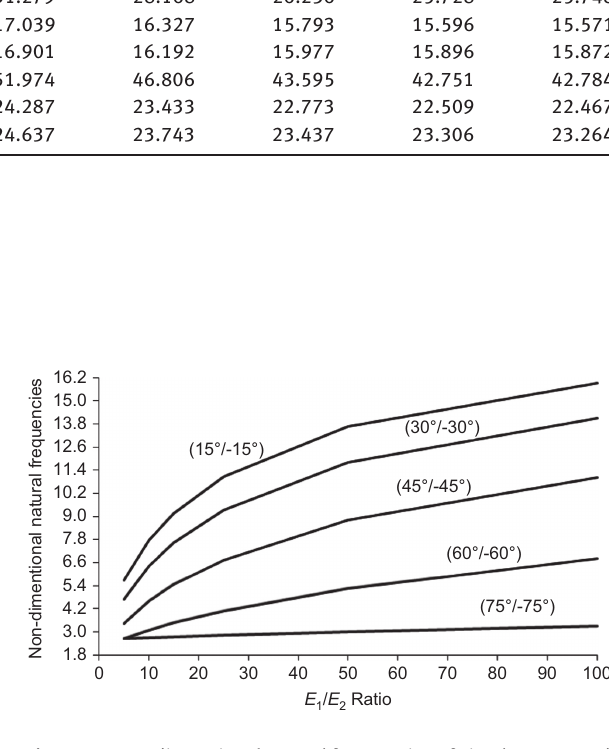
Figure 8 Non-dimensional natural frequencies of simply supported angle-ply composite beam depending on E L / h = 10.